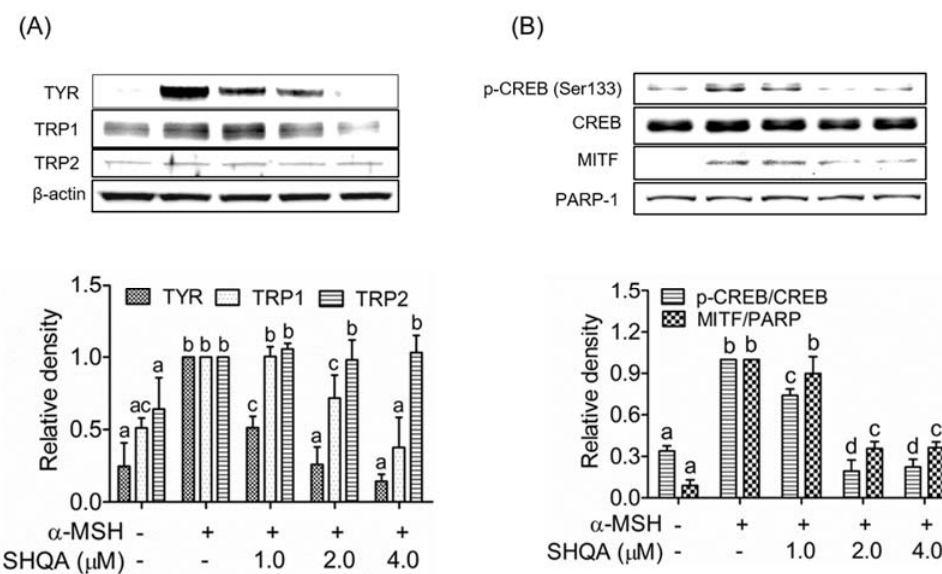
Figure 2. SHQA suppresses the protein levels of enzymes and transcription factors related to melanogenesis in B16F10 cells. ( A ) After pre-treatment of SHQA for 1 h, cells were treated with α -MSH (1.0 μ M) for 48 h with or without SHQA. Western blotting was performed for TYR, TRP1, and TRP2. After pre-treatment of SHQA for 1 h, cells were treated with α -MSH for 6 h with or without SHQA. (B) Western blotting was performed for nuclear MITF and CREB. Data represent the mean ± standard deviation SD ( n = 3). Data are expressed as the mean ± standard deviation (SD) ( n = 3). Different superscripts represent statistical significance at p < 0.05.